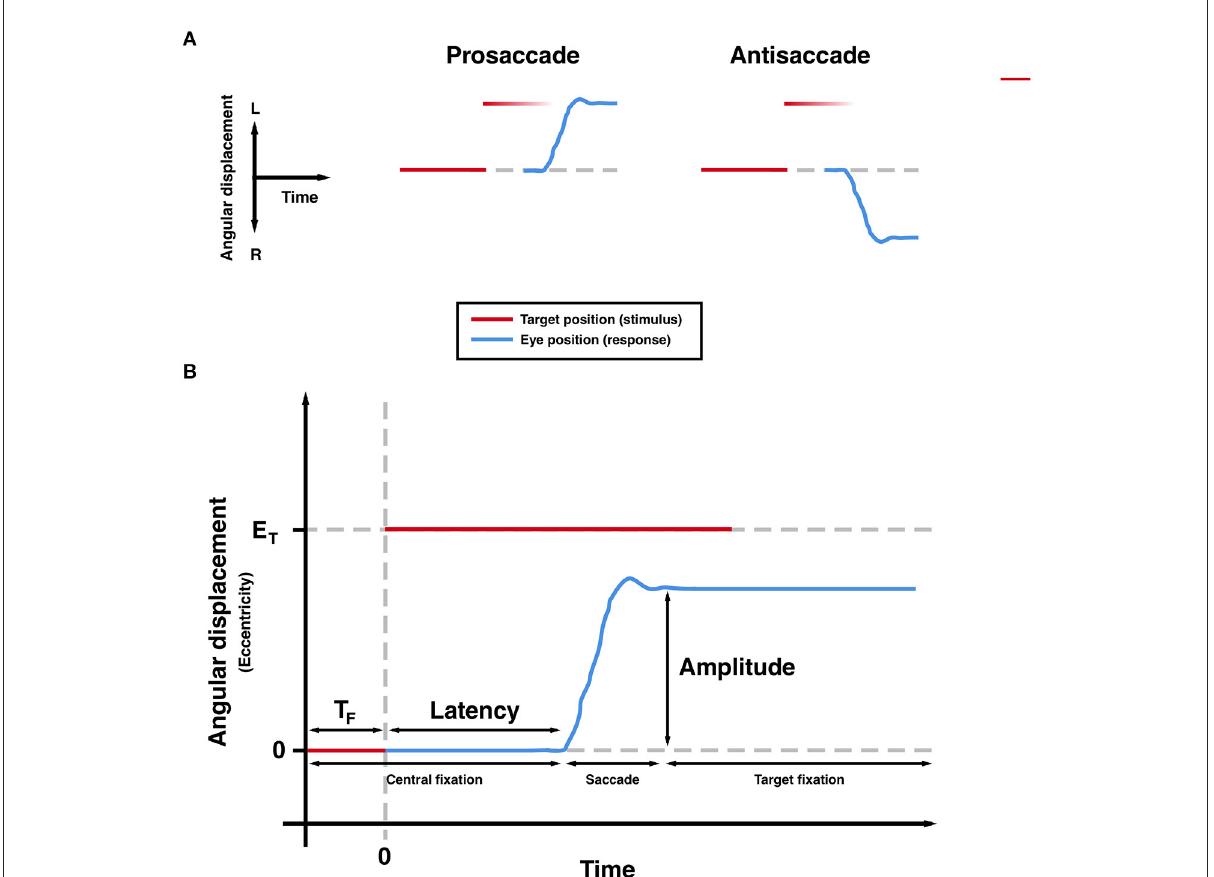
FIGURE1 Saccadic paradigms (A) and commonly measured parameters (B) . T F , foreperiod; E T , target eccentricity. Hypometria is observed in the trajectory (B)